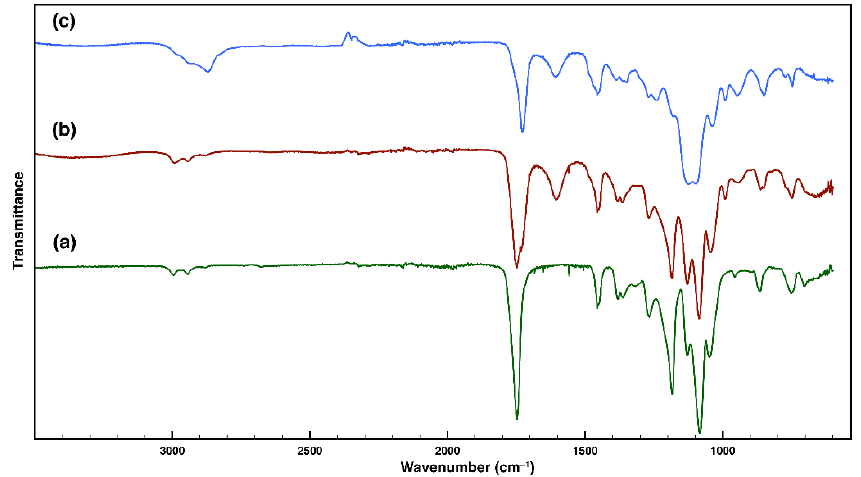
Figure 2. FTIR spectra of: ( a ) poly(D,L-lactide) (PLA, DP n = 22); ( b ) the corresponding amphiphilic PLA-b-PDMAEMA diblock copolymer (D2); ( c ) amphiphilic triblock PLA-b-PDMAEMA-b-POEGMA copolymer (T2-3).